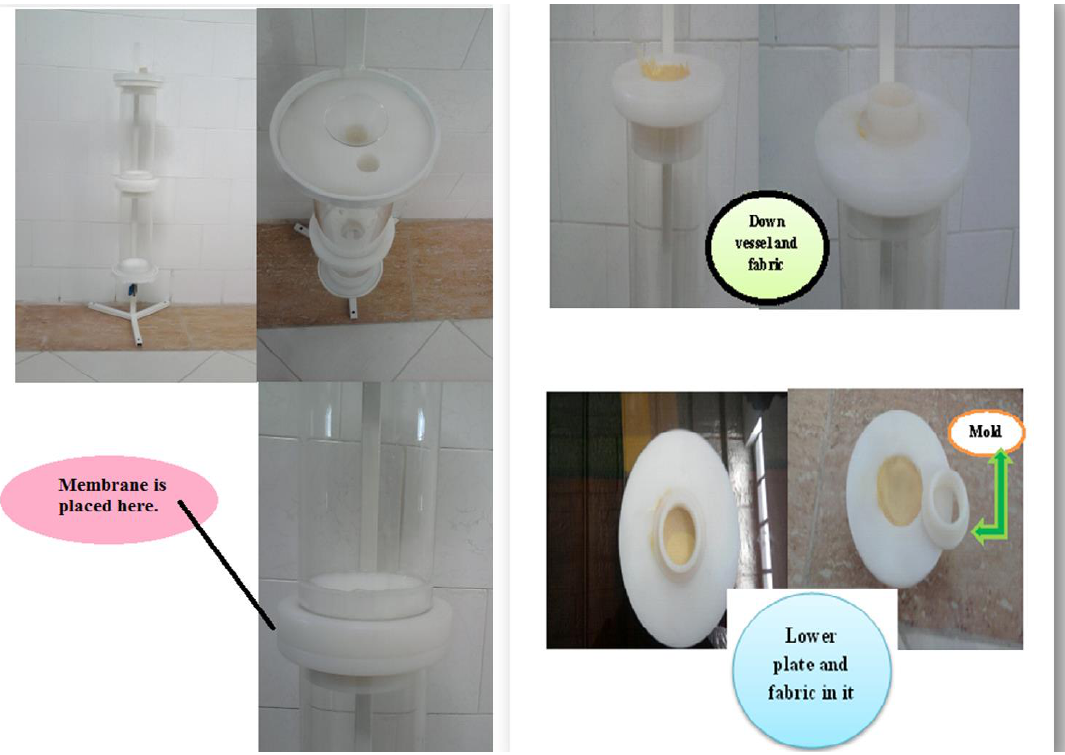
Fig. 3. Experimental setup for separation